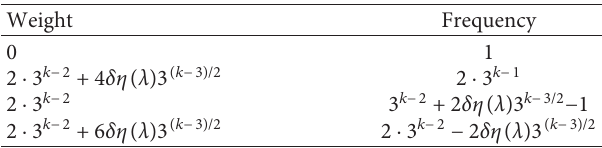
S 0 for Theorem 1